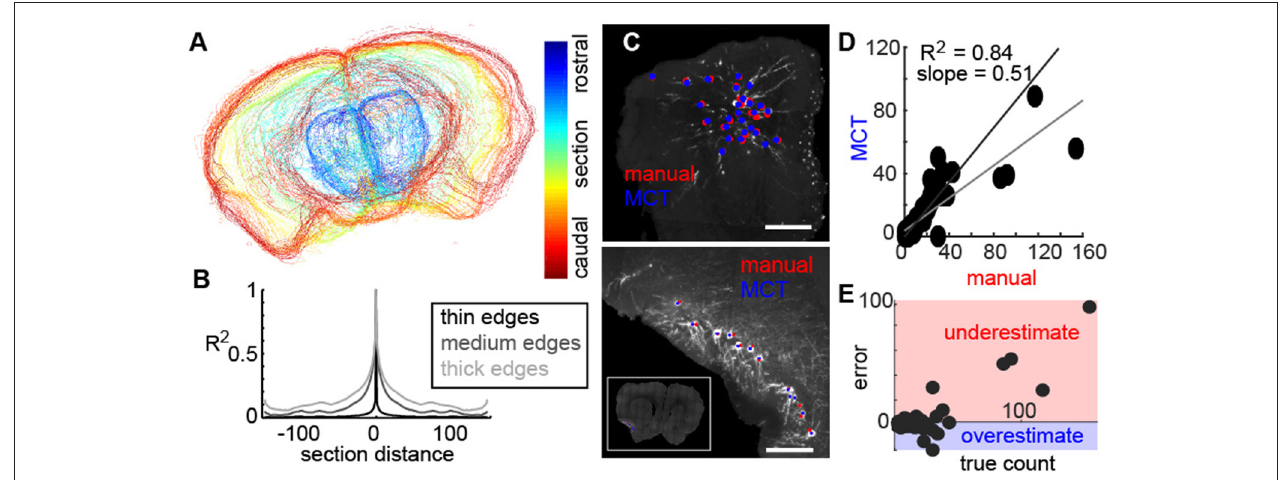
FIGURE 3 | Fidelity of aligned tissue and identified neurons. (A) Representative example of sequential sections of the mouse brain identified using MCT. (B) Correlation of each section to the sections in front and behind with varying degrees of precision (as controlled by edge thickness) shows a tight alignment of individual coronal sections in the reconstruction. (C) Representative examples of neurons manually identified (red) and using the MCT algorithm (blue) near the injection site (top) and in a section with retrogradely labeled neurons. (D) Correlation of neurons identified by the MCT algorithm to the number of neurons identified by an expert human shows a high agreement ( R 2 = 0.84). (E) Error of MCT algorithm in identifying neurons as a function of neurons labeled in the section shows that the MCT. consistently underestimates the number of labeled cells when the label density is high, likely due to poor segmentation of neurons near the injection site and when cell clusters are densely